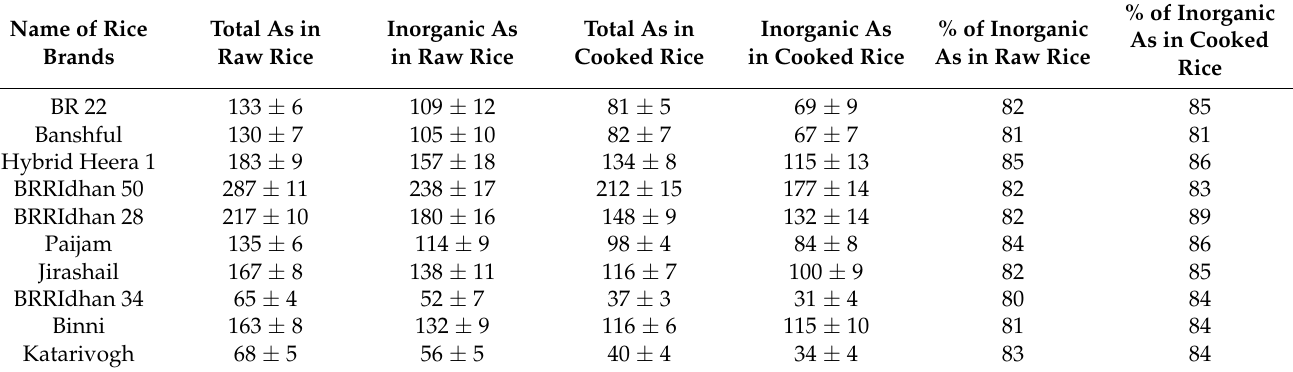
Table 1. Mean total and inorganic As concentration ( µ g/kg) in different brands of rice with recov- ery